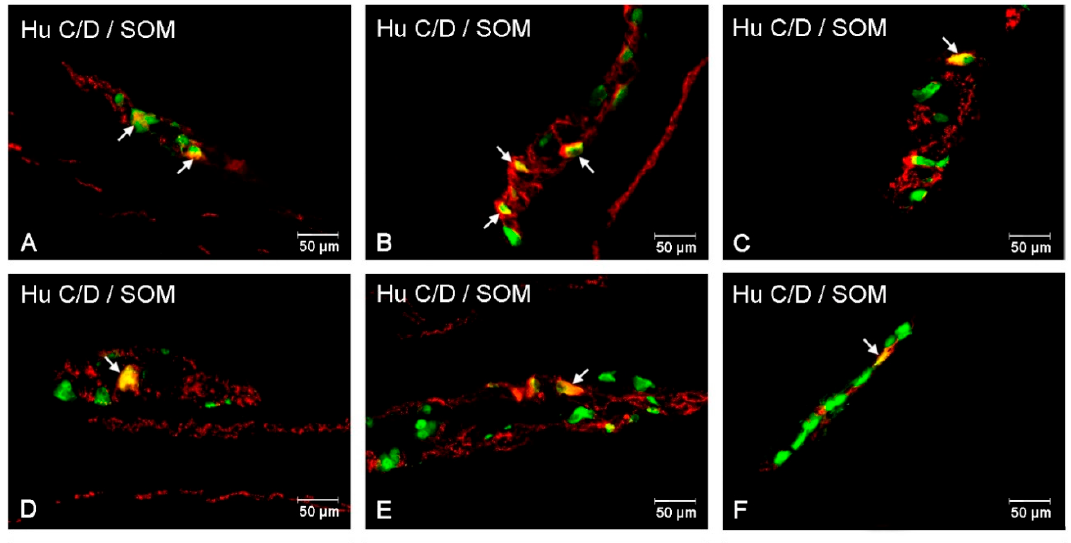
Figure 7. Intramural plexuses in the large intestine part expressing SOM. Myenteric plexus of descending colon under physiological condition ( A ) and hyperglycemic animals ( D ). Outer submucosal plexus of the descending colon in the control group ( B ) and in experimental animals ( E ). Inner submucosal plexus of the descending colon in control animals ( C ) and in diabetic animals ( F ). All photographs have been created by digital superimposition of two color channels (green for Hu C/D used here as a pan-neuronal marker, and red for SOM). Neurons showing co-localization of Hu C/D and SOM are indicated with arrows.